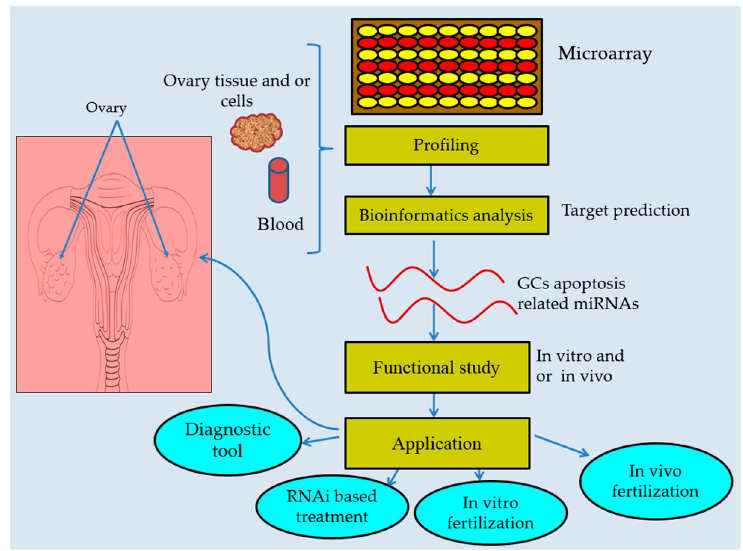
Figure 4. Diagrammatic model for miRNAs characterization and practical relevance during follicular atresia. A cluster of miRNAs have been identified by using microarray techniques and bioinformatics are used to predict their functions. Their specific role is confirmed by in vitro and/or in vivo study for clinical and biological application.